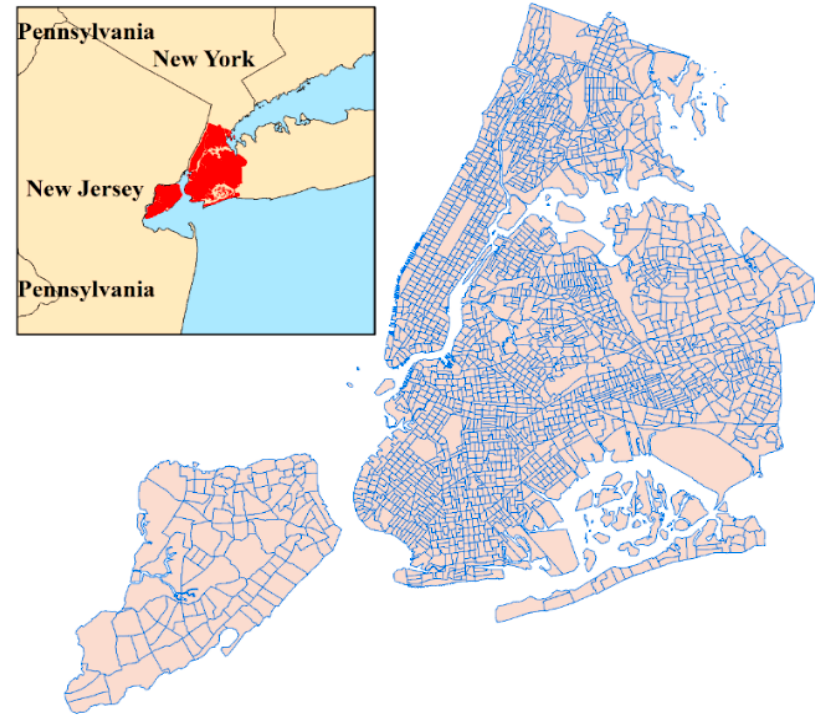
Figure 1. Study area and census tracts.